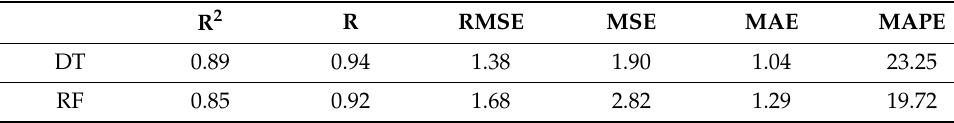
Table 3. Performance metrics for the prediction